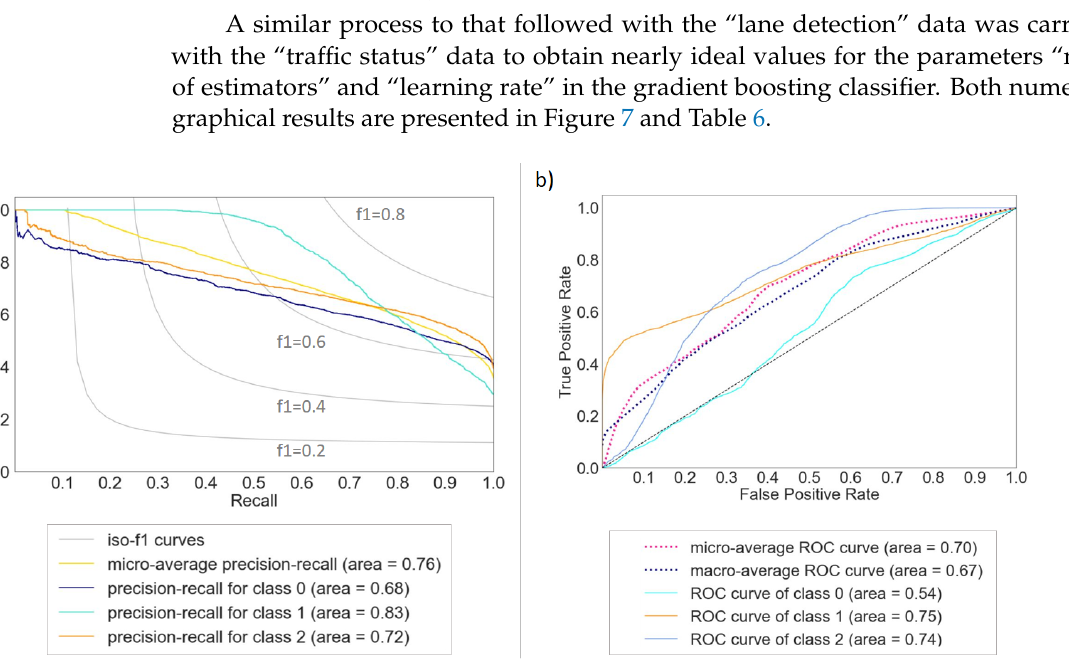
Figure 7. Gradient boosting simulation results: ( a ) precision–recall curve; ( b ) ROC curve.